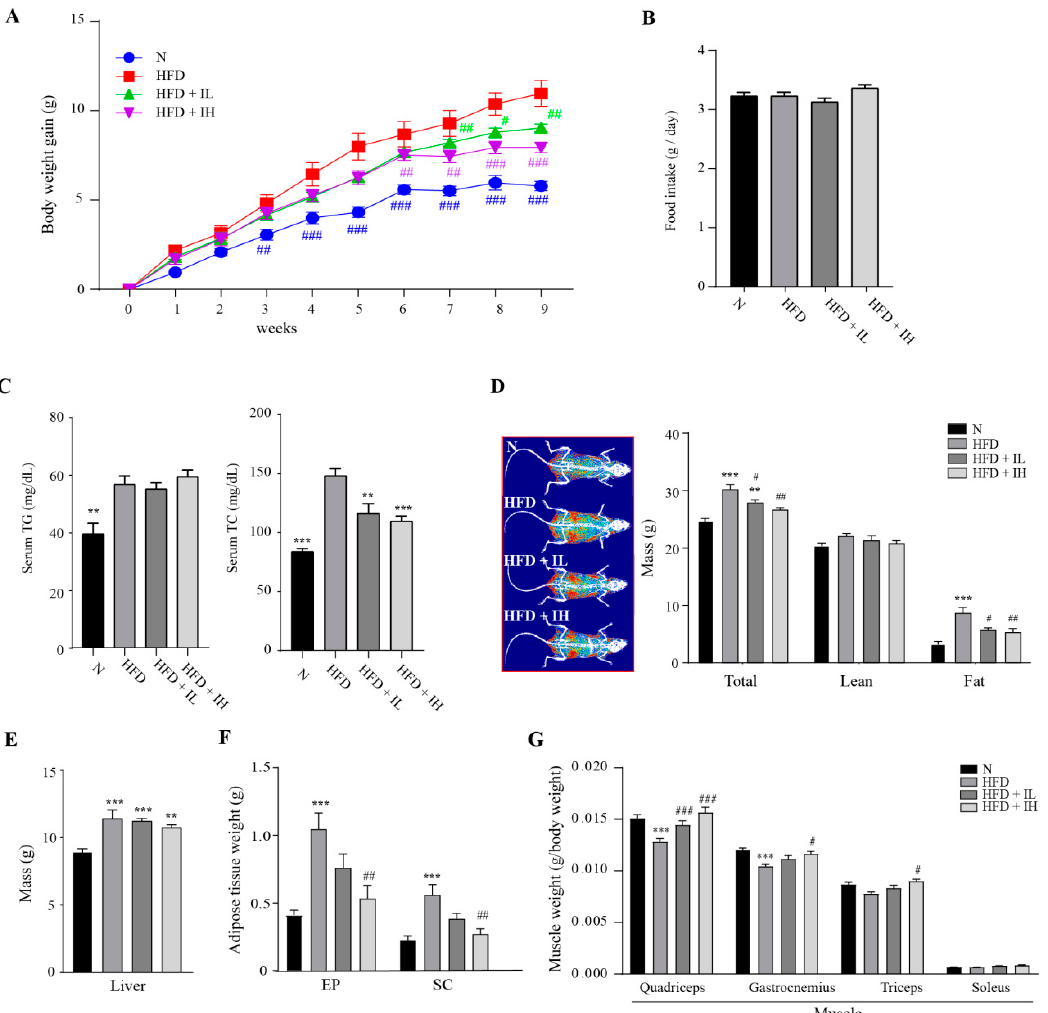
Figure 2. Effects of IJE on body weight and composition in high-fat diet (HFD)-induced obesity mice. ( A ) Body weight gain in mice fed different diets for 9 weeks ( n = 6). ( B ) Mean daily food intake. ( C ) Serum TG and TC level. ( D ) Body composition image and bar chart showing total, lean, and fat body masses measured by dual-energy X-ray absorptiometry (DEXA) ( n = 4). ( E ) Liver, ( F ) adipose tissue, and ( G ) muscle weights (g/body weight). Data are presented as mean ± standard error of the mean (SEM). ** indicates p < 0.01, whereas *** indicates p < 0.001 when compared to the N group. # indicates p < 0.05, ## indicates p < 0.01, and ### indicates p < 0.001 when compared to the HFD group. HFD, high-fat diet; HFD+IL, HFD+IJE 0.25% of diet; HFD+IH, HFD+IJE 0.5% of diet; N, normal diet.